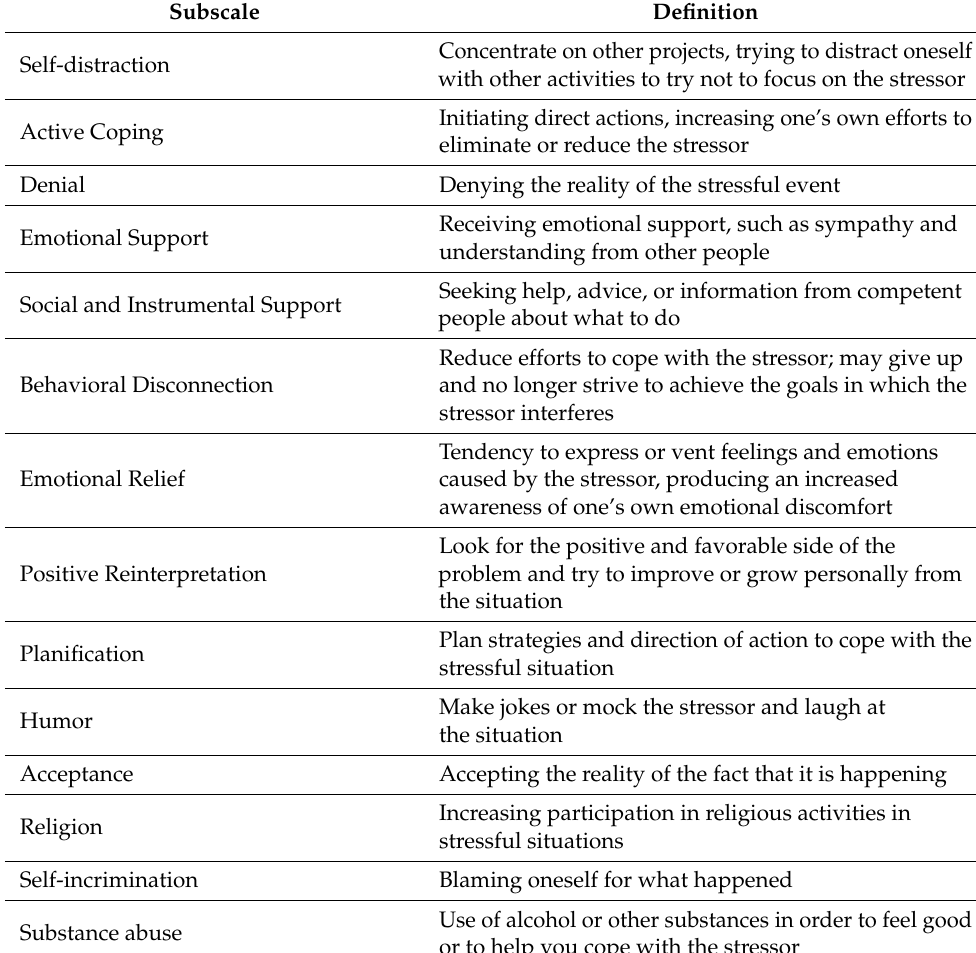
Table 1. Subscales of the Coping with Stress Scale